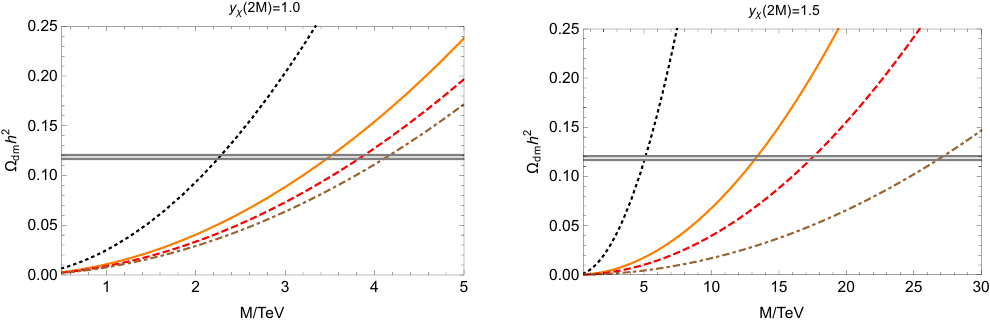
Figure 3 . Overclosure bounds for the case y (cid:31) = 1 : 0 and y (cid:31) = 1 : 5. The curves are obtained with the free cross section and with cross sections including the dark-Higgs exchange. The dark-matter dark-Higgs mass ratio is (cid:12)xed according to the three choices M=m s = 10 ; 20 ; 50 and the color code is as in (cid:12)gure